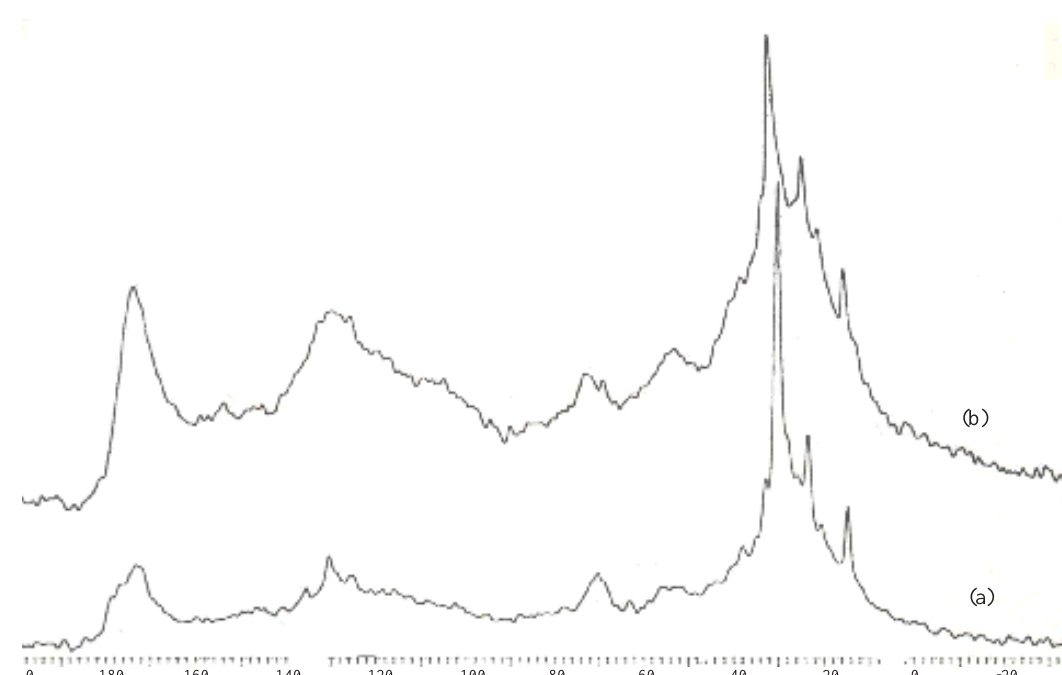
Figura 3. Espectro de RMN 13 C CP/MAS de AH extraídos de composto de resíduos sólidos urbanos (a) e de lodo da estação de tratamento de esgoto